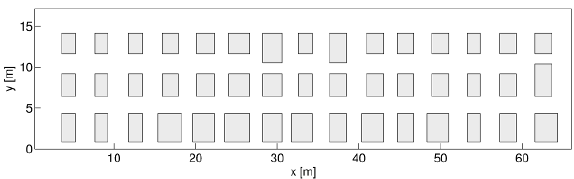
Figure 11. Final windows for the façade shown in Figure 6.